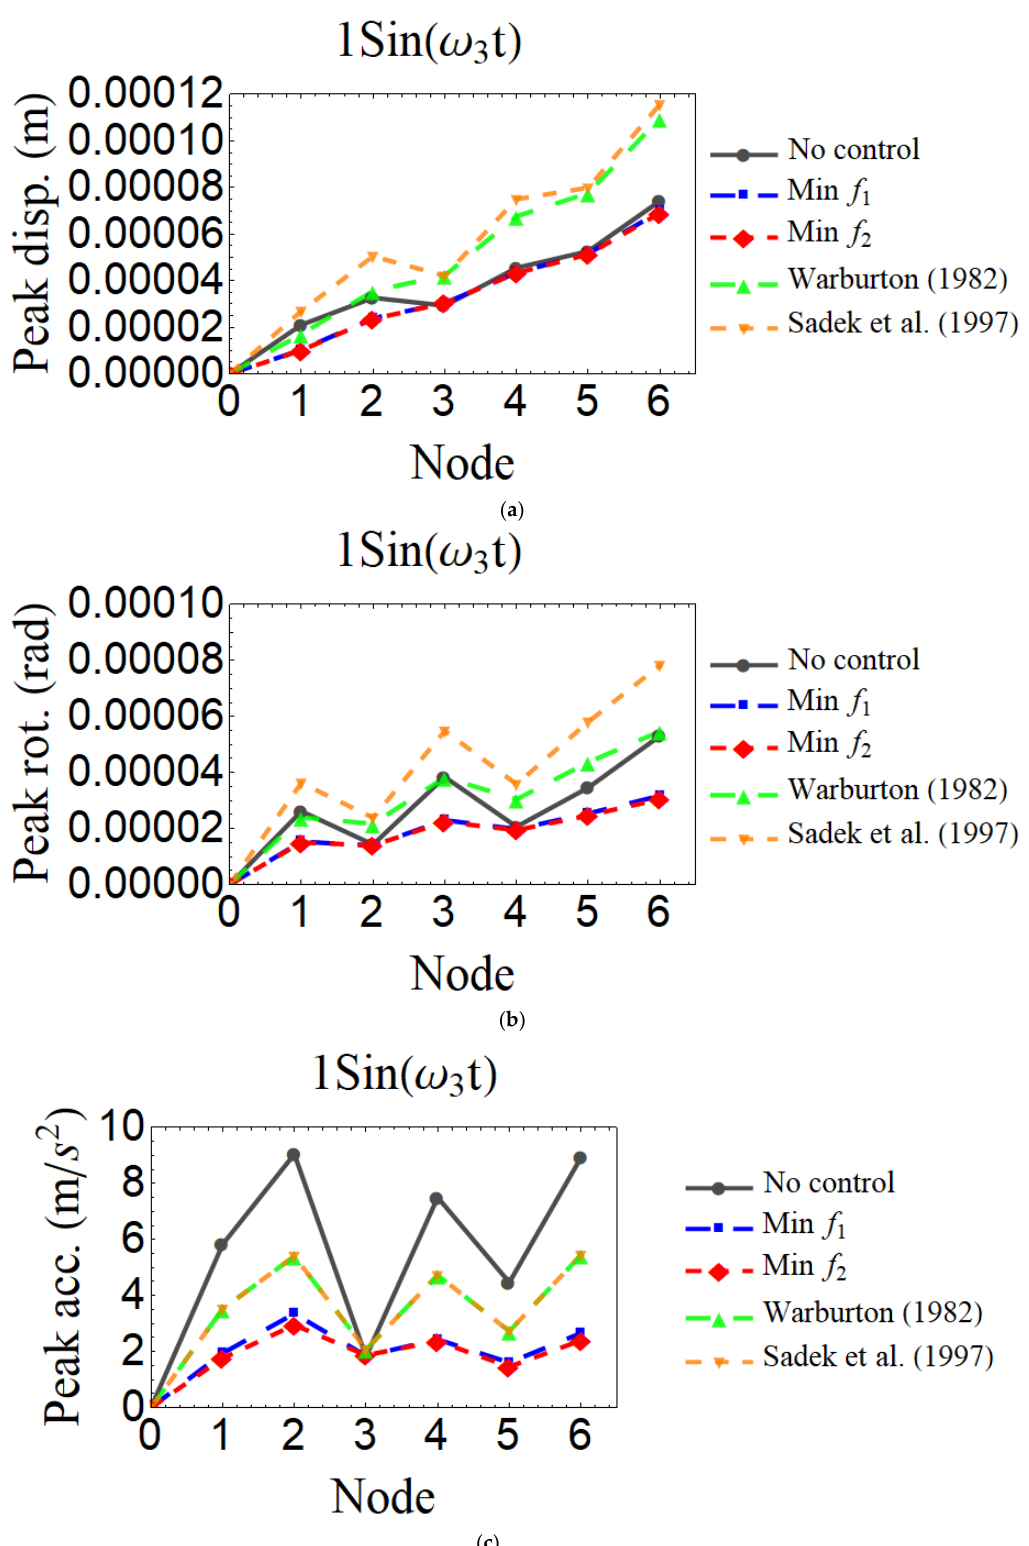
Figure 13. The peak node responses of the cantilever beam in comparison with [29], [30] for the third mode control considering the f 1 and f 2 objective functions: ( a ) peak displacements, ( b ) peak rotations, and ( c ) peak accelerations.